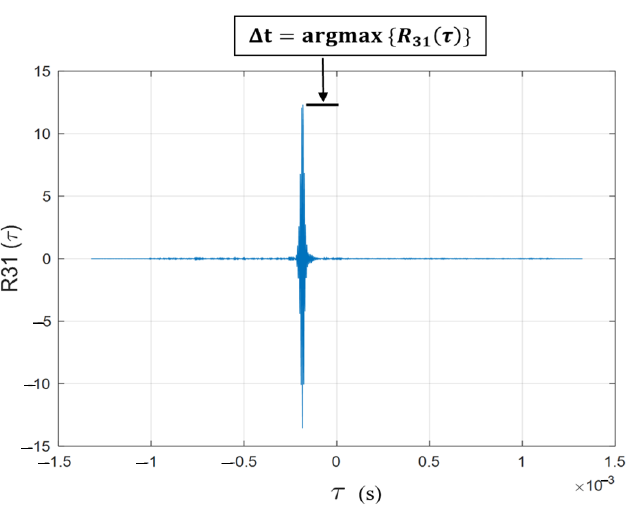
Figure 6. Cross-correlation function between waveforms from two locations on the tie (1 and 3) to compute the differential